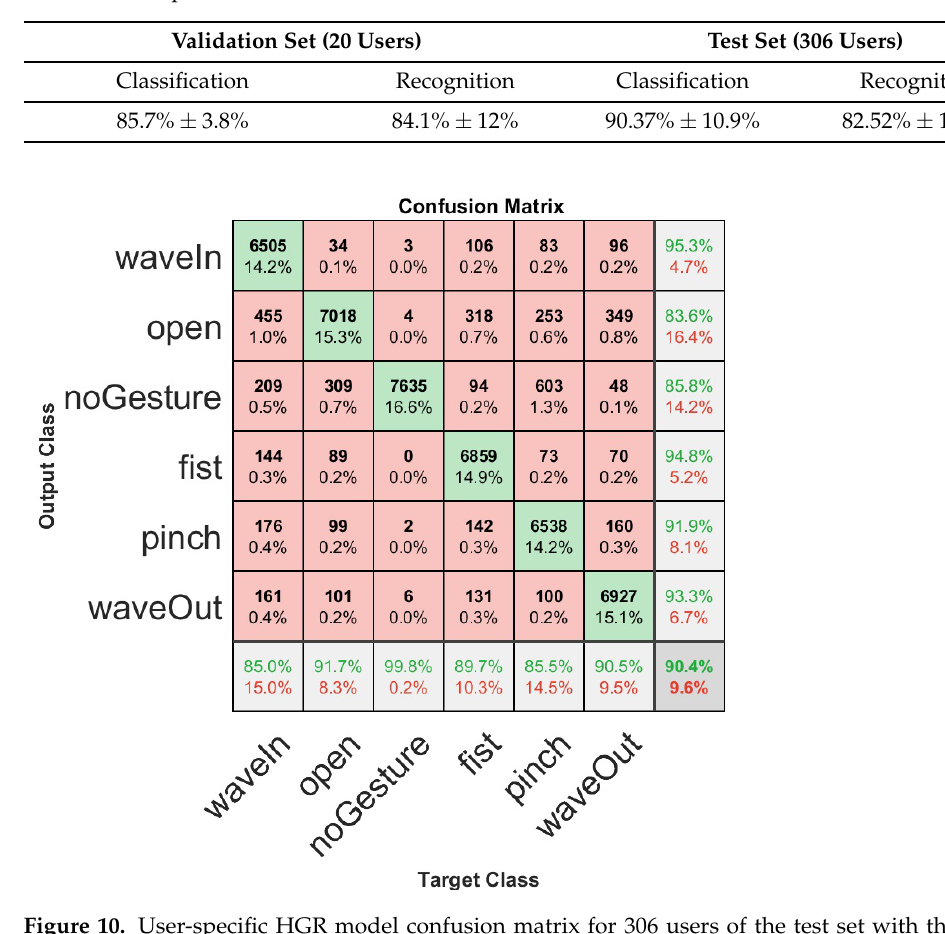
Table 3. User-specific validation and test results of the HGR best model.